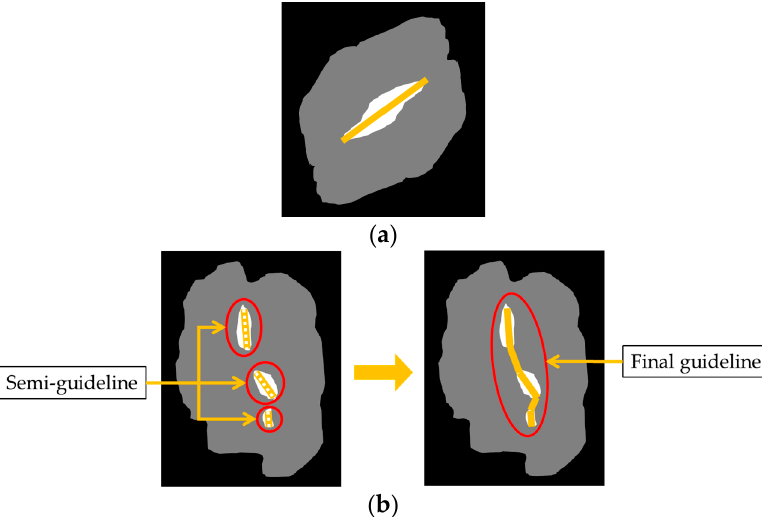
Figure 11. Generation of a guideline with a single hole and multiple holes: ( a ) Case 1: guideline with a single hole; ( b ) Case 2: guideline with multiple holes.